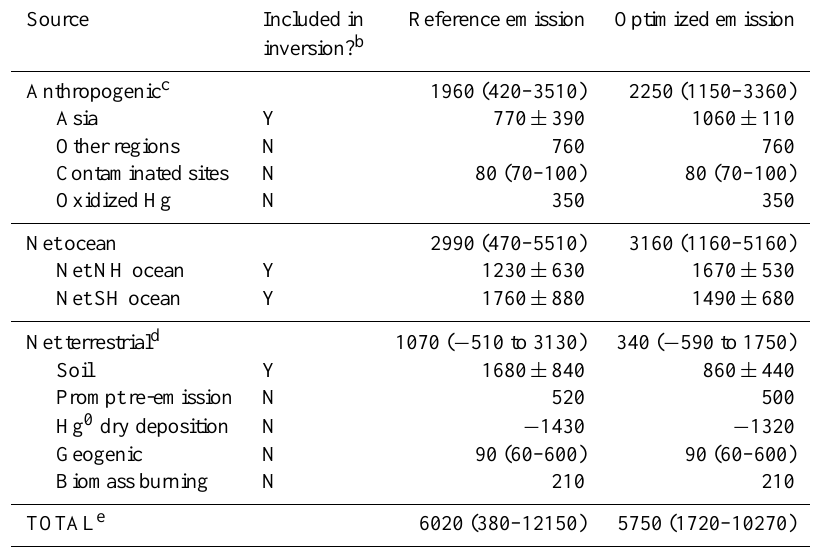
Table 2. Global mercury emissions into the atmosphere (Mgyr − 1 ).